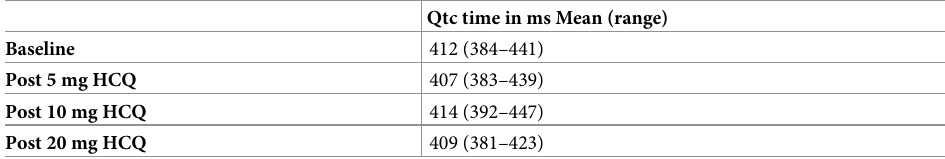
Table 5. QTc time at baseline and 3,5 hours after